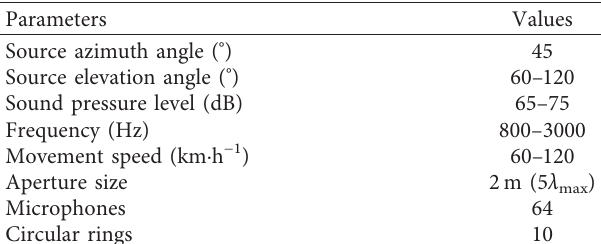
Table 1: Simulation parameters.